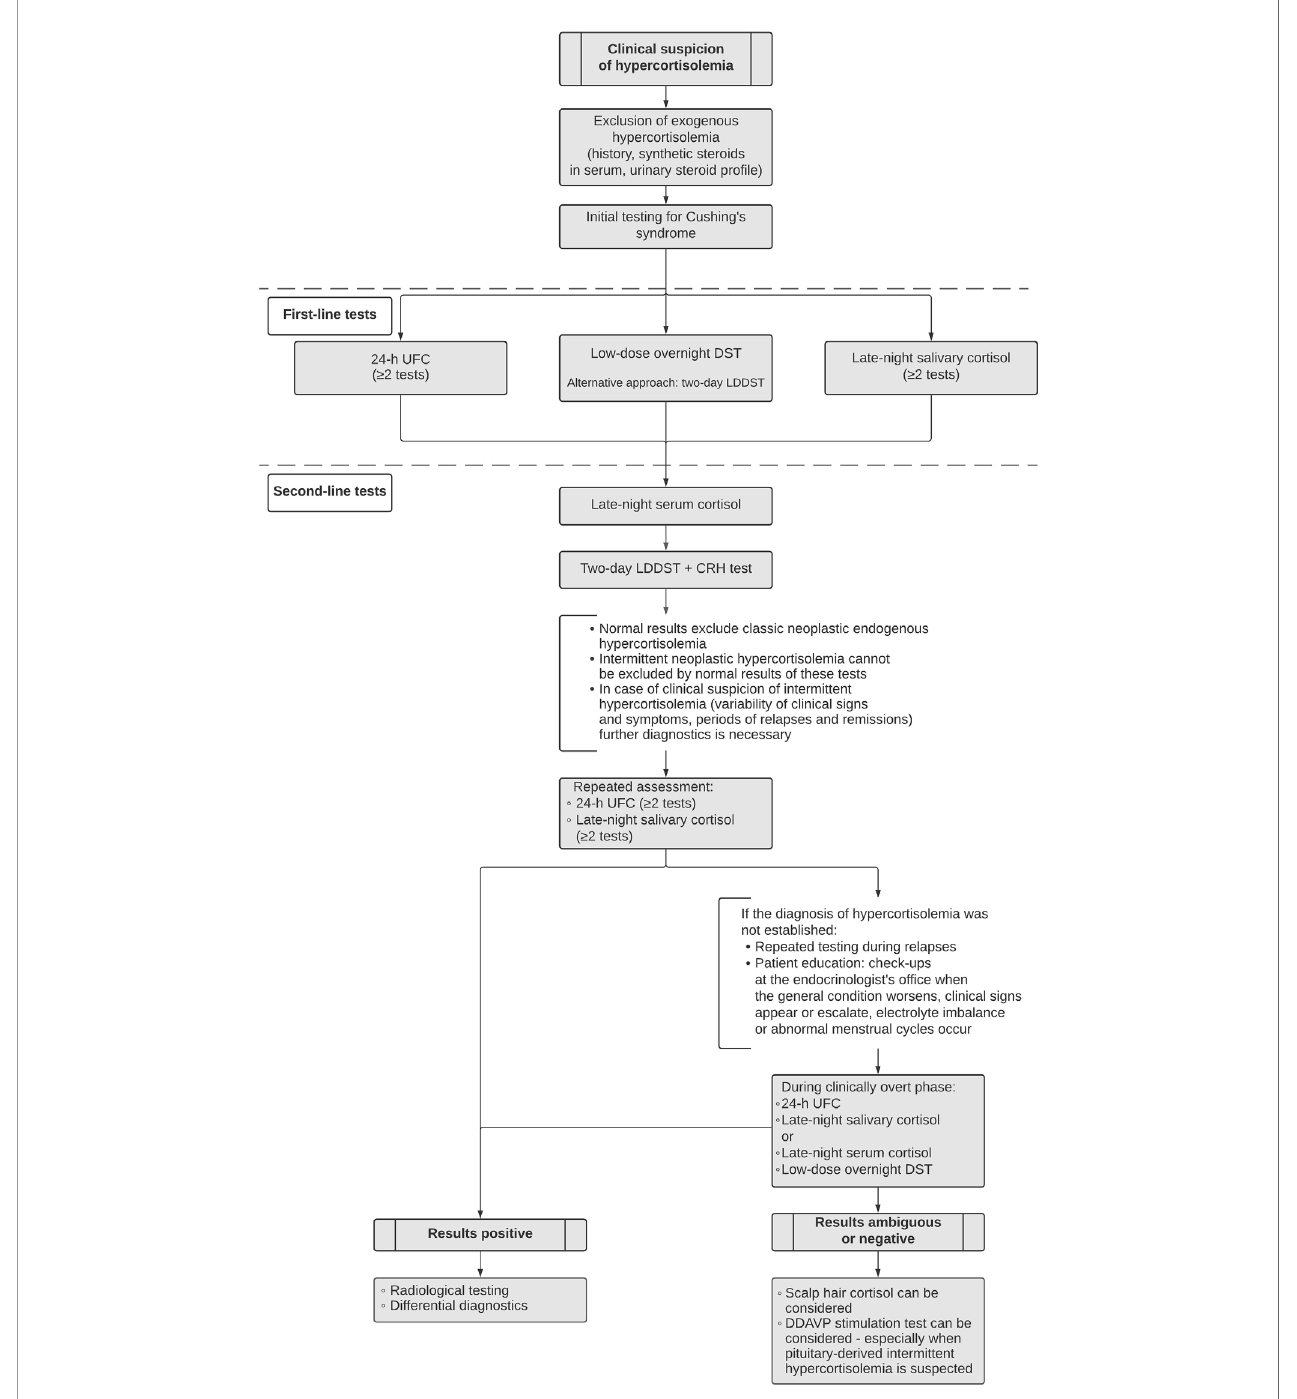
FIGURE 1 | Proposed diagnostic algorithm for suspected cyclic Cushing ’ s